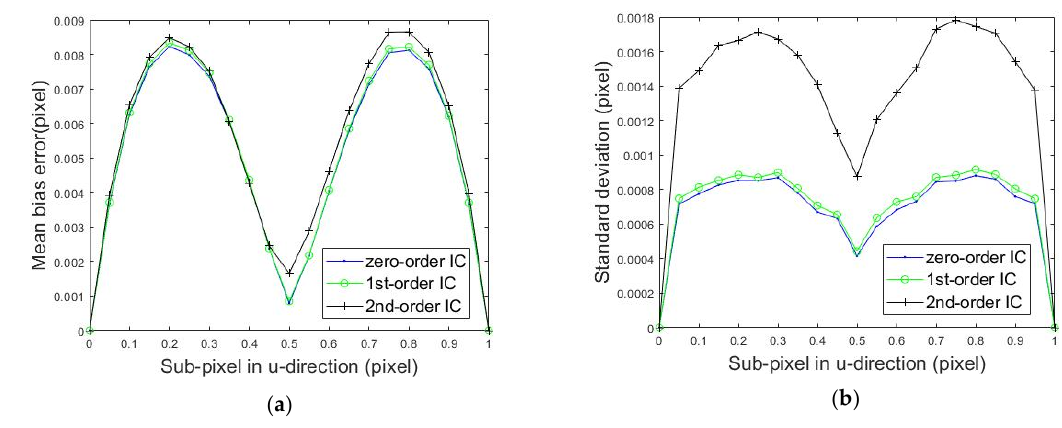
Figure 7. Calculated errors of the rigid body translation compared to the set sub-pixel values. ( a ) Mean bias error and ( b ) standard deviation.